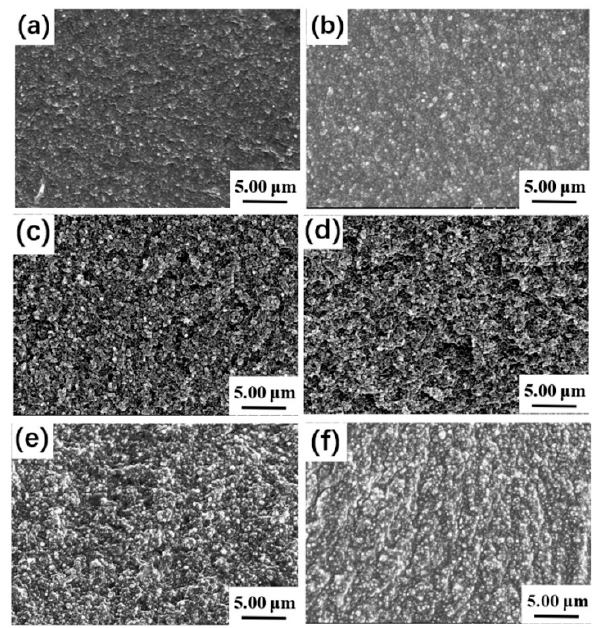
Figure 8. Scanning electron microscope graphs of ( a ) PDEBEG-50 / CB, ( b ) PDEBEG-40 / CB, ( c ) PDEBEG-30 / CB, ( d ) PDEBEG-20 / CB, ( e ) PDEBEG-10 / CB, ( f ) PDEBEG-0 / CB.